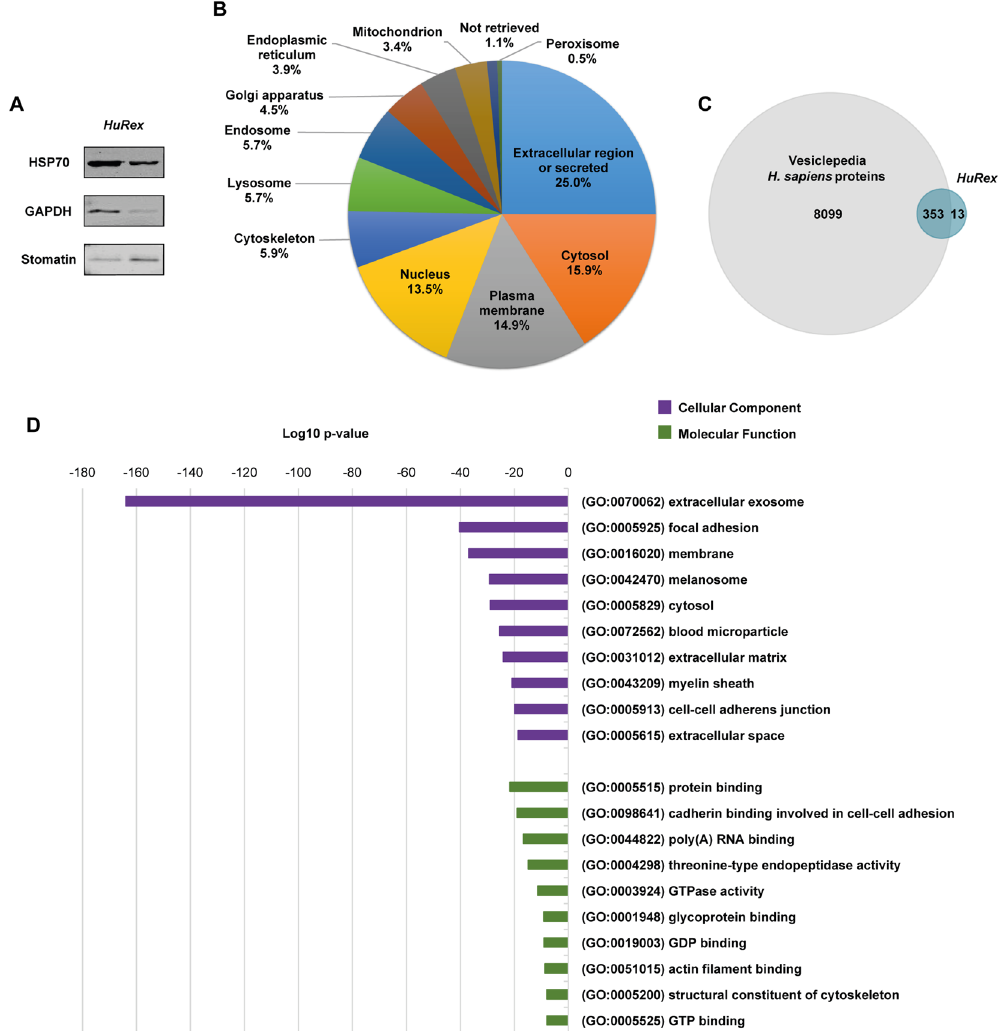
Figure 3. Proteome of human reticulocyte-derived exosomes identified by LC-MS/MS. ( A ) Western blot validation for HSP70, GAPDH and stomatin on UC- HuRex . Samples were purified from two cord blood donors, each one loaded in a different lane. (B) Distribution of the proteome of HuRex in subcellular location categories retrieved from UniProt database according to Gene Ontology (GO) annotation. (C) Venn diagram showing the overlap of proteins detected in HuRex and those reported in Vesiclepedia, a database of extracellular vesicle cargo 30 . (D) GO term-enrichment analysis of HuRex proteome at cellular component and molecular function level performed with Database for Annotation, Visualization and Integrated Discovery (David 6.8) 60 . The most over-represented GO terms are